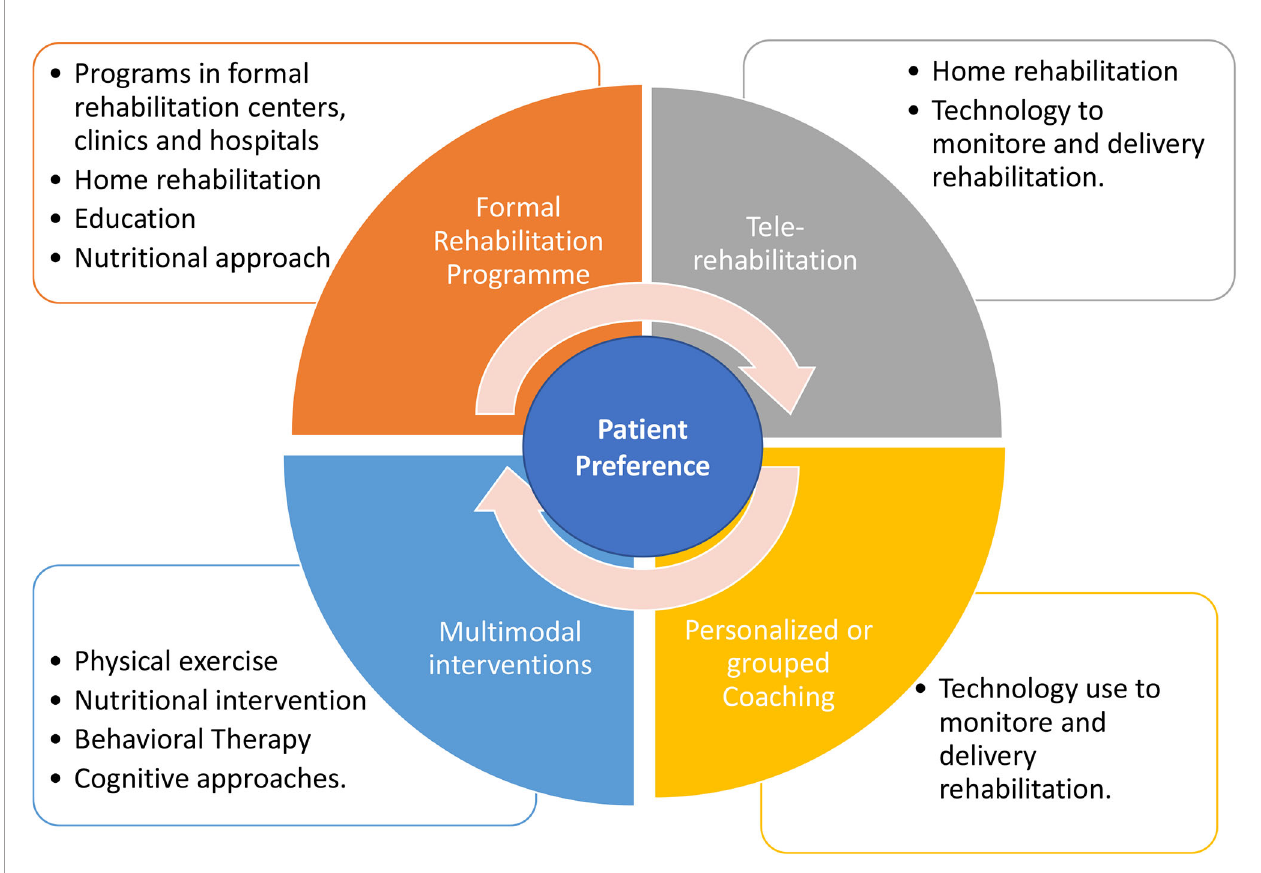
FIGURE 1 | Summary of components of rehabilitation program on the population with T2DM considering the patient